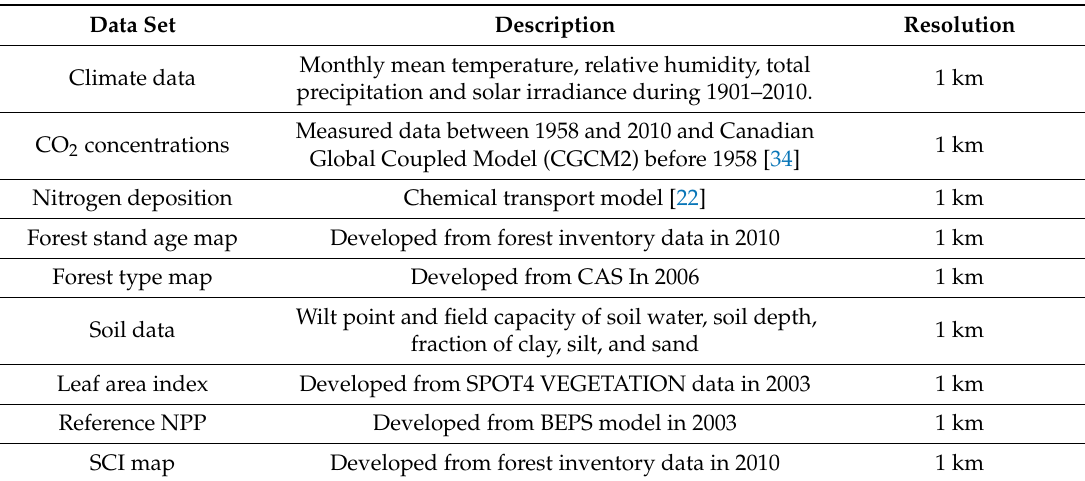
Table 1. Descriptions of input data used in the InTEC